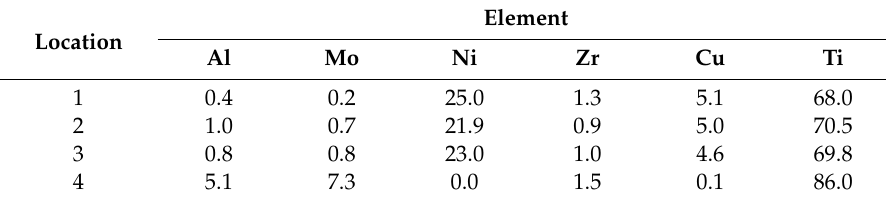
Table 4. Electron probe micro-analyzer (EPMA) chemical compositions in at% of marked sites in Figure 9. Element Location Al Mo Ni Zr Cu Ti 1 0.4 0.2 25.0 1.3 5.1 68.0 2 1.0 0.7 21.9 0.9 5.0 70.5 0.8 0.8